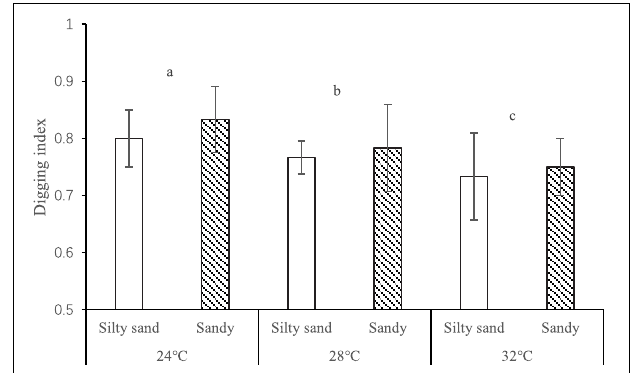
FIGURE 3 | Digging index of Manila clam at different temperatures and in different sediment types. The different letters indicate significant difference of digging index at different temperatures.